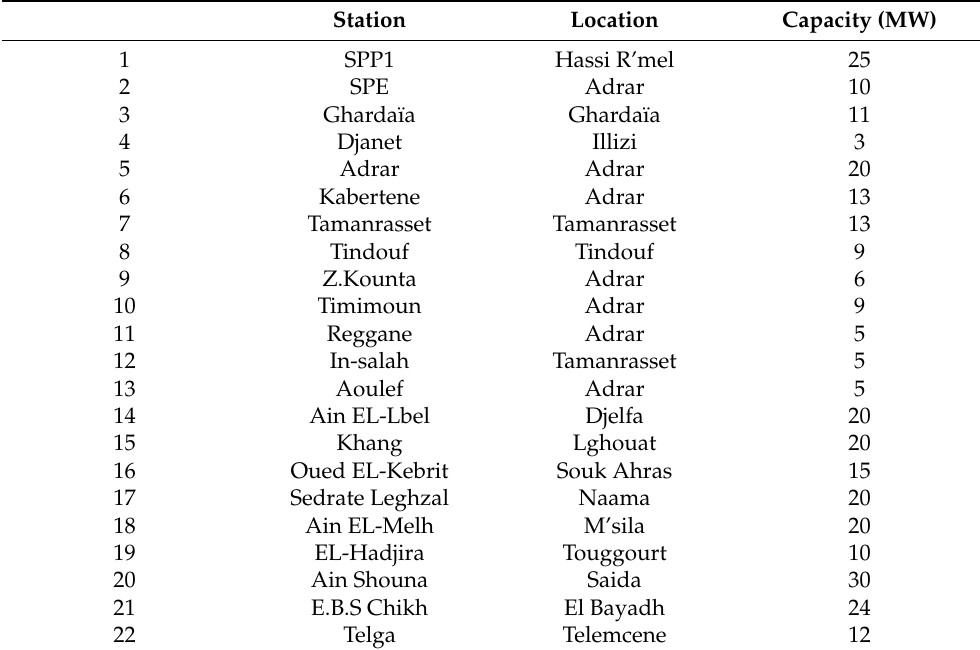
Table 7. Installed solar generation stations [6].